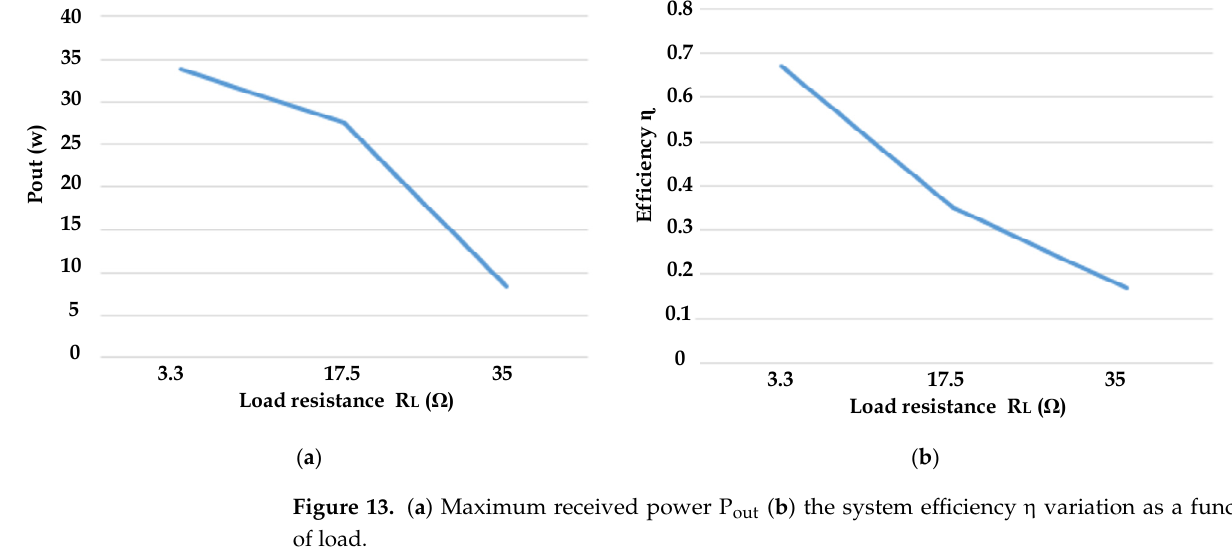
Figure 13. ( a ) Maximum received power P (cid:2925)(cid:2931)(cid:2930) ( b ) the system efficiency η variation as a function of load.